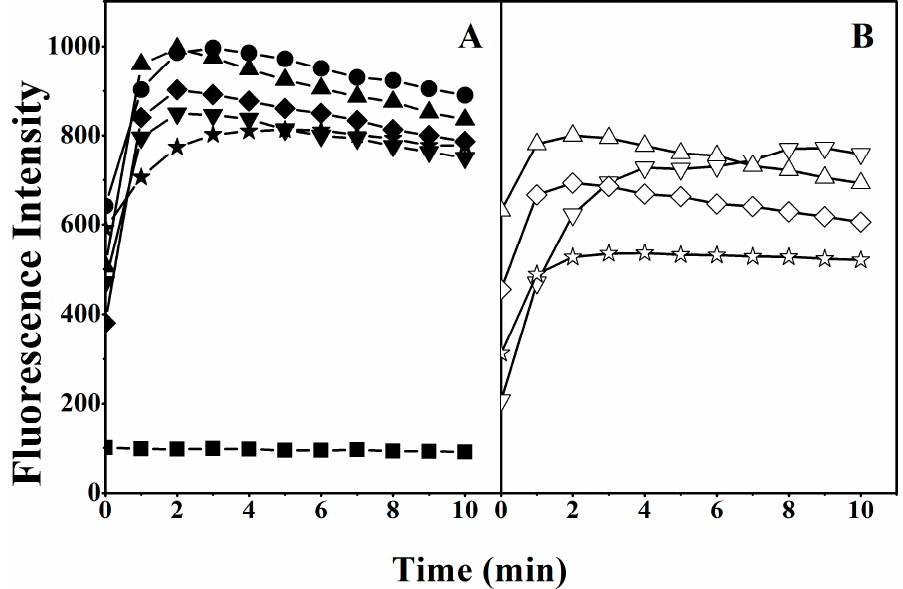
Figure 2. Membrane permeabilization assay of the peptides. Outer membrane permeabilization induced by the peptides was detected by NPN uptake in E. coli . Panel ( A ) denotes the peptides with substitutions on the polar face and Panel ( B ) denotes the peptides with substitutions on the non-polar face. Symbols used are as follows: ● for V13K; ▲ for K14 D ; ▼ for S11 D /K14 D ; ◆ for K14 D /T15 D ; ★ for S11 D /T14 D /T15 D ; △ for A12 D ; ∇ for F9 D /A12 D ; ◊ for A12 D /V16 D ; and ☆ for F9 D /A12 D /V16 D ; ■ for Control.